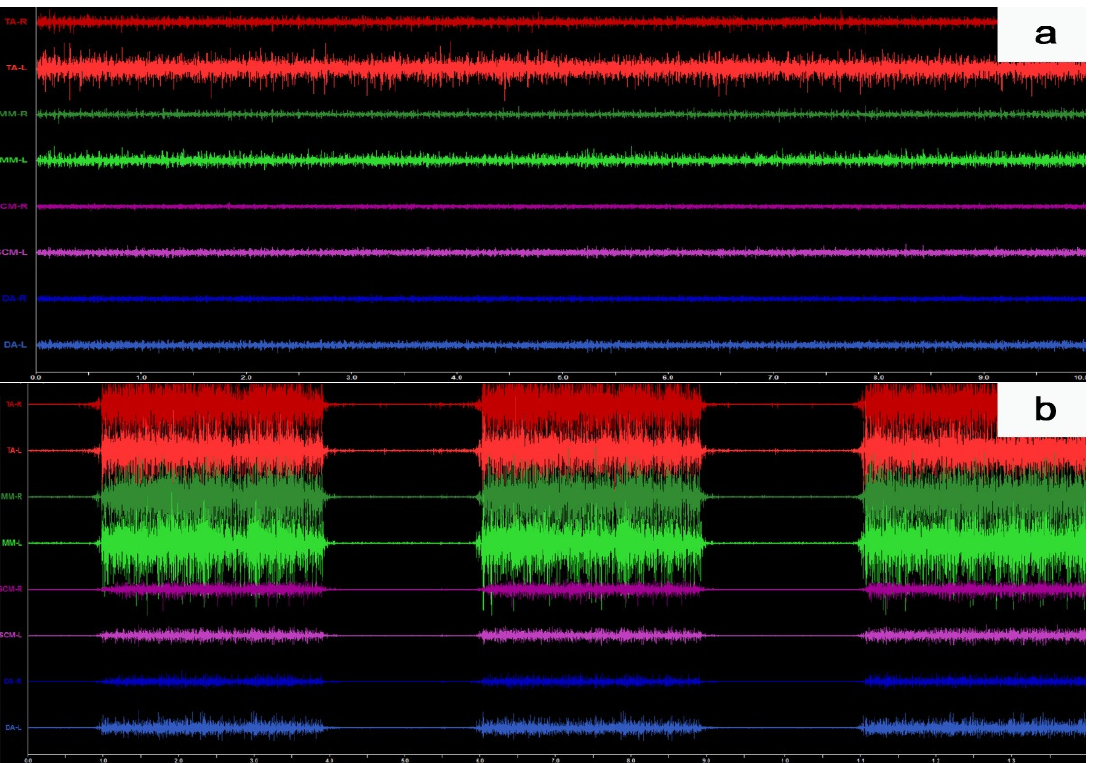
Figure 2. Example of the surface electromyography traces during resting activity ( a ) and maximum voluntary clenching in the intercuspal position ( b ).